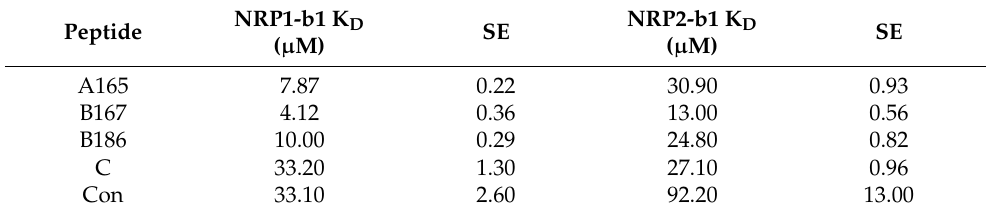
Table 2. Dissociation constants for interactions between the VEGF-derived peptides and the b1 domains of NRP1 and NRP2, as determined by surface plasmon resonance experiments. SE is a standard error for the K D